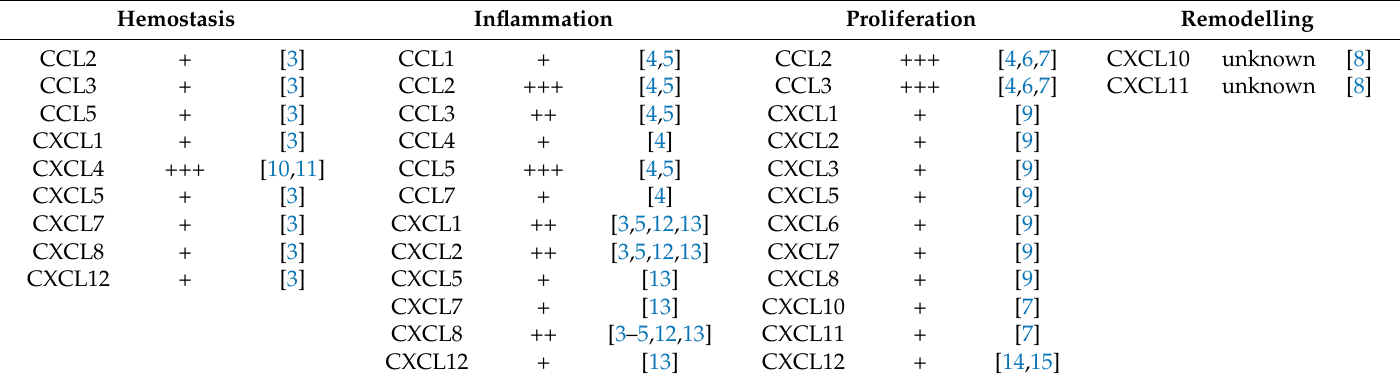
Table 1. Chemokines in different stages of wound